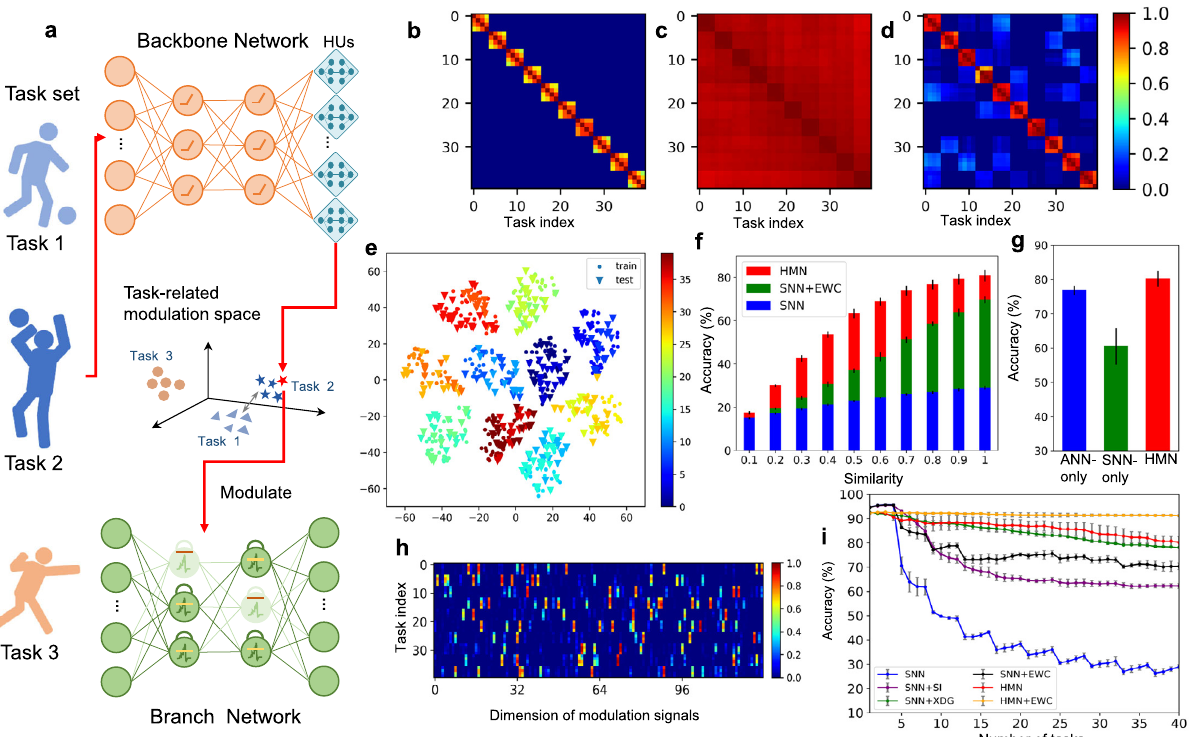
Fig. 3 HMN for MCL tasks. a Architecture of HMN, consisting of an ANN-based backbone network to extract task-level information and an SNN-based branch network to perform speci fi c tasks. Learnable HUs are adopted for adaptively adjusting modulation signals to meet the requirements of the branch network. The HUs are installed at the backend of the backbone network (Fig. 1e-(1)), and are jointly trained by the task similarity objective. b Similarity matrix of tasks, calculated based on the Hamming distance between the permutation indices of tasks in this experiment. c , d The correlation matrix of mean activations of hidden neurons of the HMN and the single SNN, respectively. e T-SNE embeddings of the sample-speci fi c modulation signals generated by the backbone network. The triangle denotes the modulation signal of the test samples of the backbone network. f Mean accuracy of different models on unlearned tasks with different levels of similarity. g Mean accuracy of the ANN-only model and the SNN-only model with a similar architecture of HMN, respectively. h The fi rst 128 dimensions of the task-speci fi c modulation signals before thresholding. i Mean accuracy of different models on learned tasks versus the number of learned tasks. All the experiments in this demo are independently run four times with the same setting. The error bar represents the standard deviation of the